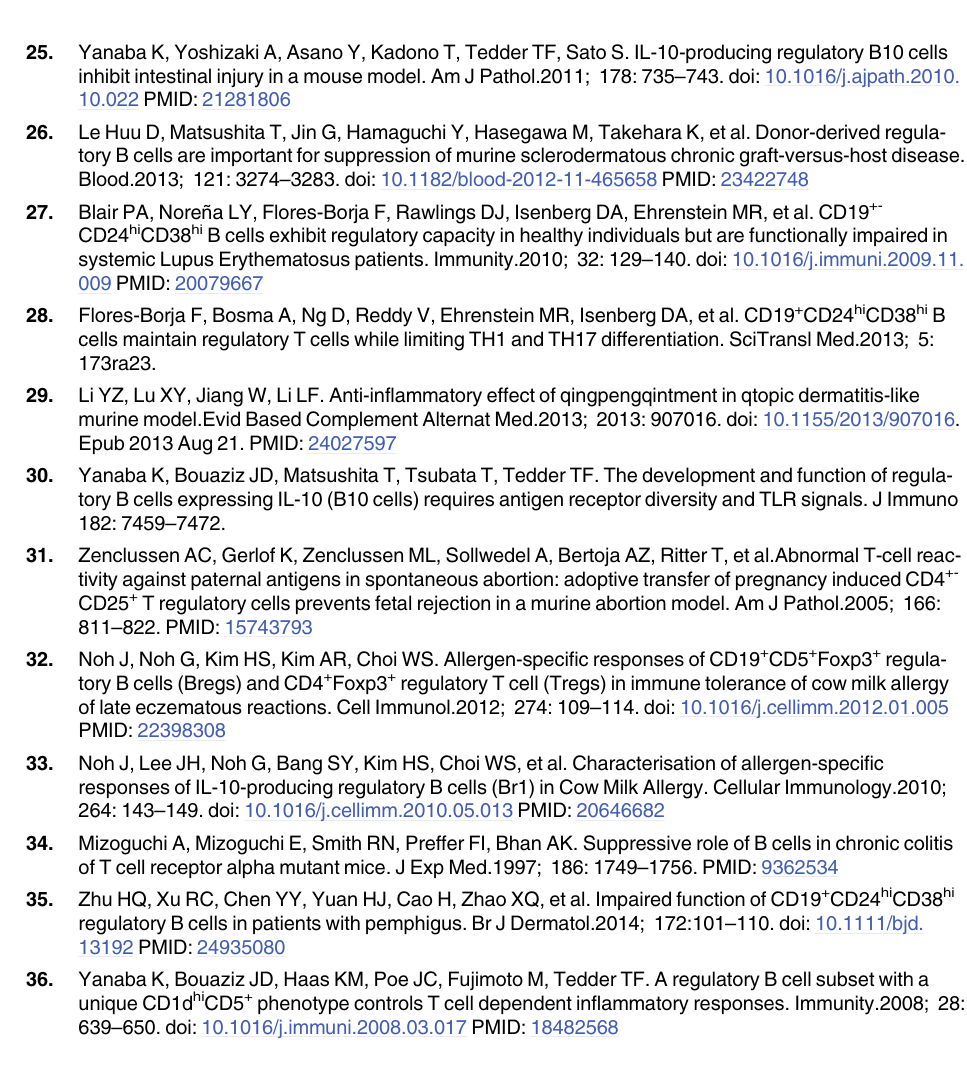
PLOS ONE | DOI:10.1371/journal.pone.0132173 August 5,